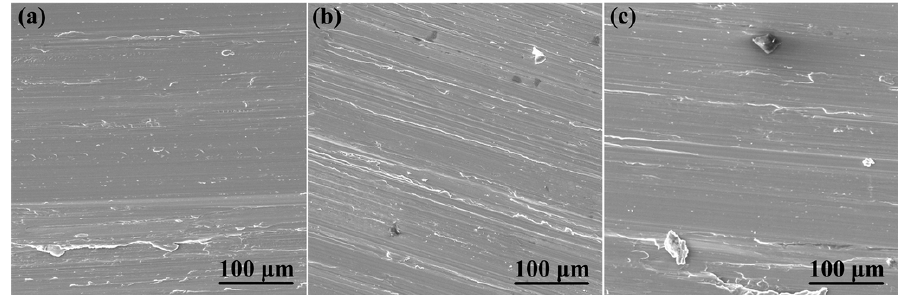
Figure 12. Worn surface morphologies of UIRP samples at 478 r/min after ( a ) 100 cycles, ( b ) 200 cycles and ( c ) 300 cycles.